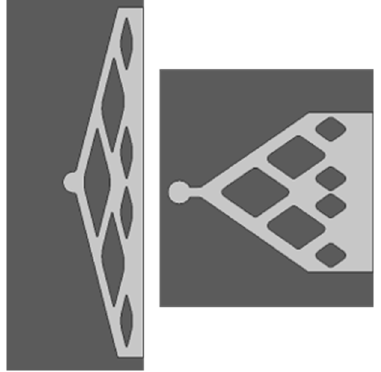
Figure 4. Design of the inlet geometries.